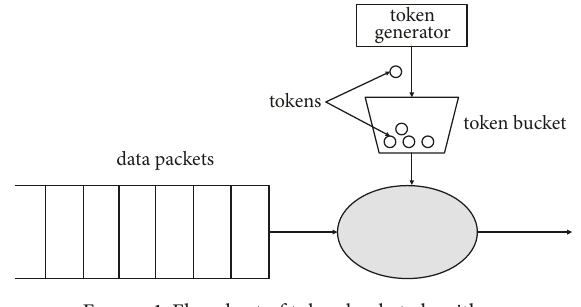
Figure 1: Flowchart of token bucket